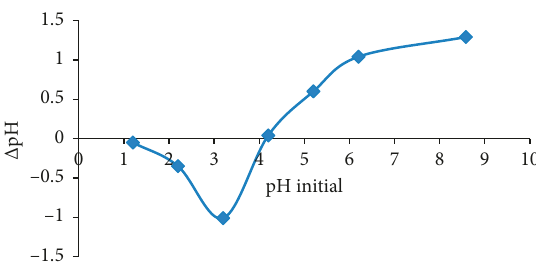
Figure 6: Point of zero charge (pH